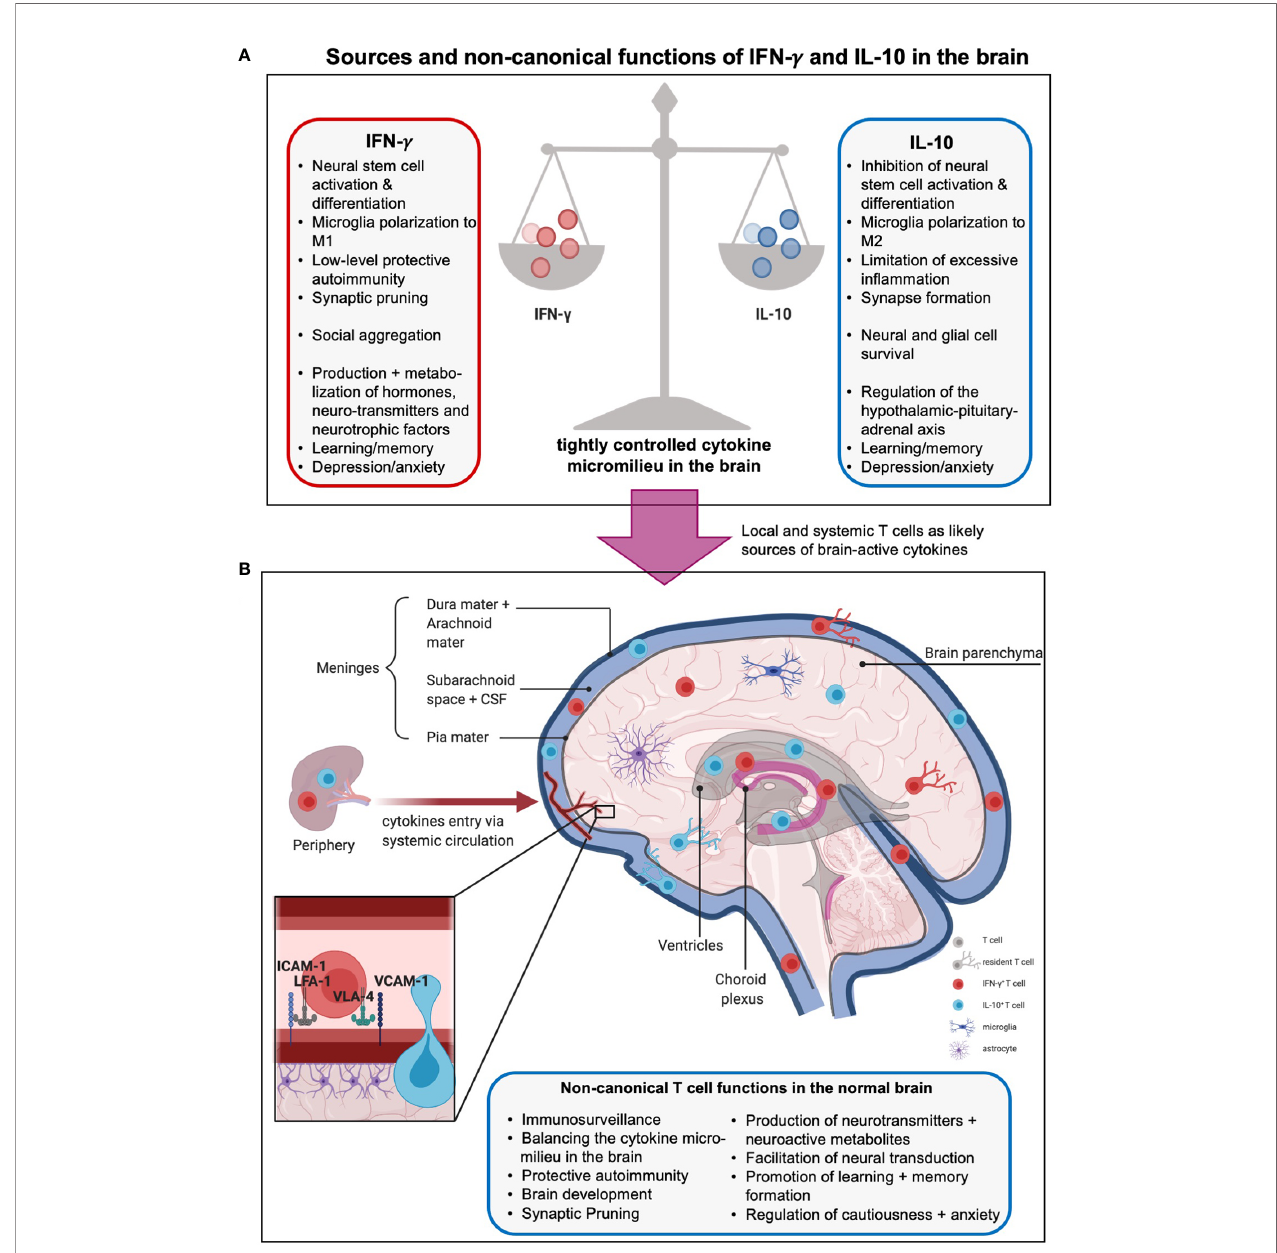
FIGURE 3 | Sources and non-canonical functions of IFN- g and IL-10 in the brain. (A) The cytokine milieu in and around the brain is tightly controlled to allow bene fi cial, hemostatic low-level autoimmunity but prevent excessive in fl ammation. Thus, pro-in fl ammatory local IFN- g which promotes neural differentiation and synaptic pruning is restrained by local presence of anti-in fl ammatory, stemness preserving, and synapses formation supporting IL-10. The boxes summarize further unique and shared functions of these cytokines in metabolism, hormone regulation, and behavioral control (see text for more details). (B) The origins of IFN- g - and IL- 10 in the central nervous system (CNS) are not fully delineated. Sources include production by local tissue-resident cells such as microglia and astrocytes, in fl ux from the periphery via a compromised blood-brain barrier (BBB), and/or, production by T cells residing in or are adjacent to the brain parenchyma, meninges, choroid plexus, circumventricular organs and ventricles. Brain-associated T cells enter these regions mainly via the recently discovered meningeal lymphatics, and/or extravasation through endothelial cells lining blood vessels within the CNS, and/or crossing the BBB involving an ICAM-1- or VCAM-1-mediated mechanisms (insert). Brain T cells can be resident or patrolling and mediate immunosurveillance and protection against infection but also the normal development and physiological activities of the brain, including host behavior and emotions via production of effector molecules (cytokines, neuro-active metabolites, neurotransmitters, etc., see text for more details). Moreover, CD4 + T cells have been shown to produce neurotransmitters as well as further neuromodulating agents and metabolites such as glutamate and lactate, regulate neural synapse formation and mediate neural transduction. Of note, the effects of T cells on neural functions and emotions are complex and strongly in fl uenced by spatial and temporal context and micromilieu in the